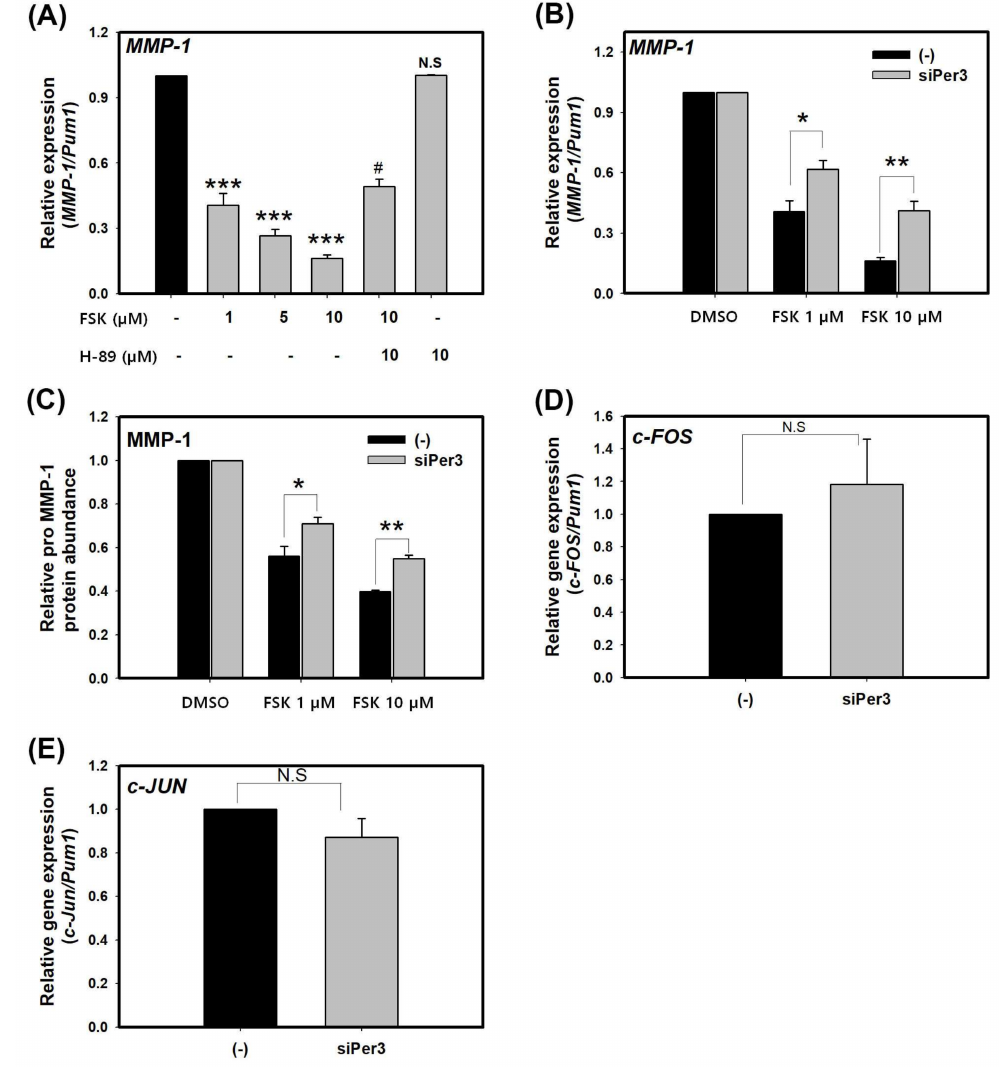
Figure 2. cAMP suppresses the expression of MMP-1 through PER3 in HaCaT cells. ( A ) Levels of MMP-1 transcripts in HaCaT cells treated with DMSO (-), FSK, and H-89 at indicated concentration for 24 h (two-tail unpaired, n = 3, * p < 0.05, ** p < 0.01, *** p < 0.001, N.S.: not significant compared with DMSO only (-) and # p < 0.05 compared with 10 uM FSK); ( B ) Levels of MMP-1 transcripts in HaCaT cells treated with control-siRNA or siPer3 for 48 h, followed by co-treatment with FSK and siRNA for 24 h; ( C ) Levels of pro MMP-1 proteins in cell supernatants of HaCaT treated with control-siRNA or siPer3 for 48 h, followed by co-treatment with FSK and siRNA for 24 h (in B , C , one-way ANOVA, followed by Bonferroni post hoc, n = 3, * p < 0.05, ** p < 0.01 compared with control-siRNA at the indicated concentration) levels of c-Fos ( D ) and c-Jun ( E ) transcripts in aCaT cells treated with control-siRNA or siPer3 for 72 h (Two-tail unpaired, n = 3, N.S.: not significant compared with control-siRNA). Data are presented as mean ± SEM from three replicated measurements. Data is the relative value compared with control group in ( A , D , E ) or compared with respective control group (control-siRNA or siPer3 at DMSO) in ( B , C